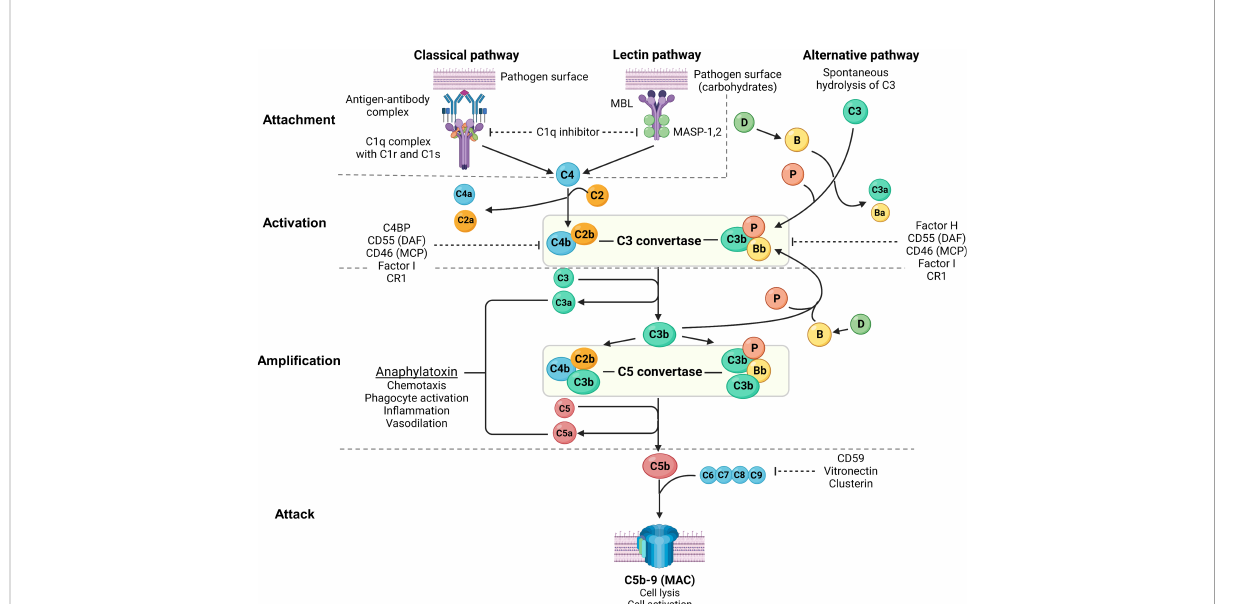
FIGURE 2 Overview of the complement system. Created with BioRender.com. MBL, mannan-binding lectin; MASP, mannan-binding lectin serine protease; C4BP, C4b-binding protein; DAF, decay-accelerating factor; MCP, membrane cofactor protein; CR1, complement receptor 1; MAC, membrane attack complex; C3aR, C3a receptor; C5aR, C5a receptor; PMN, primary membranous nephropathy; PLA2R, M-type phospholipase A2 receptor 1; THSD7A, thrombospondin type-1 domain-containing protein 7A. The complement system consists of 3 pathways: classical pathway, lectin pathway and alternative pathway, which can be conceptually understood using 4A ’ s: attachment, activation, ampli fi cation, and attack (steps of complement activation in bold text below). In the classical pathway, complement C1q attaches to the Fc receptor of antigen-bound